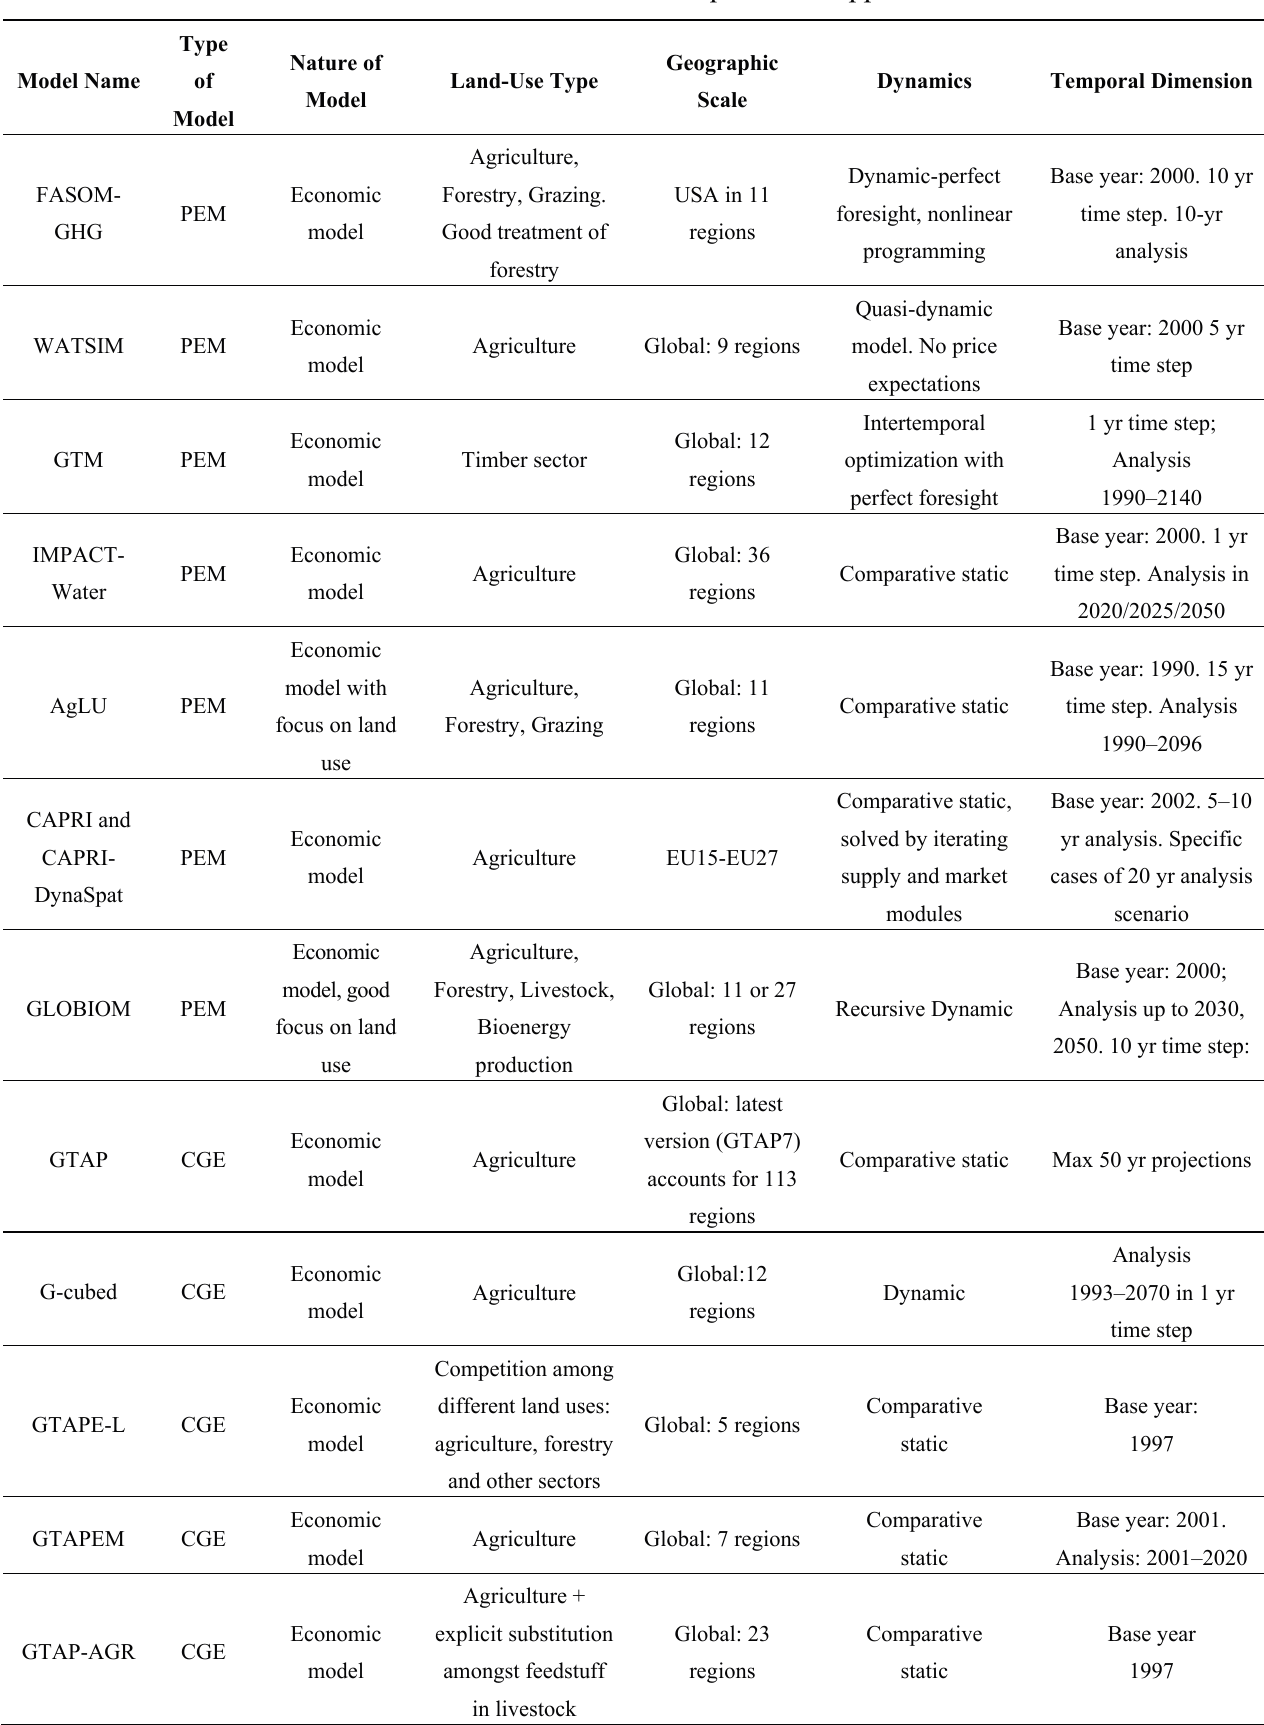
Table 3. Main characteristics of equilibrium